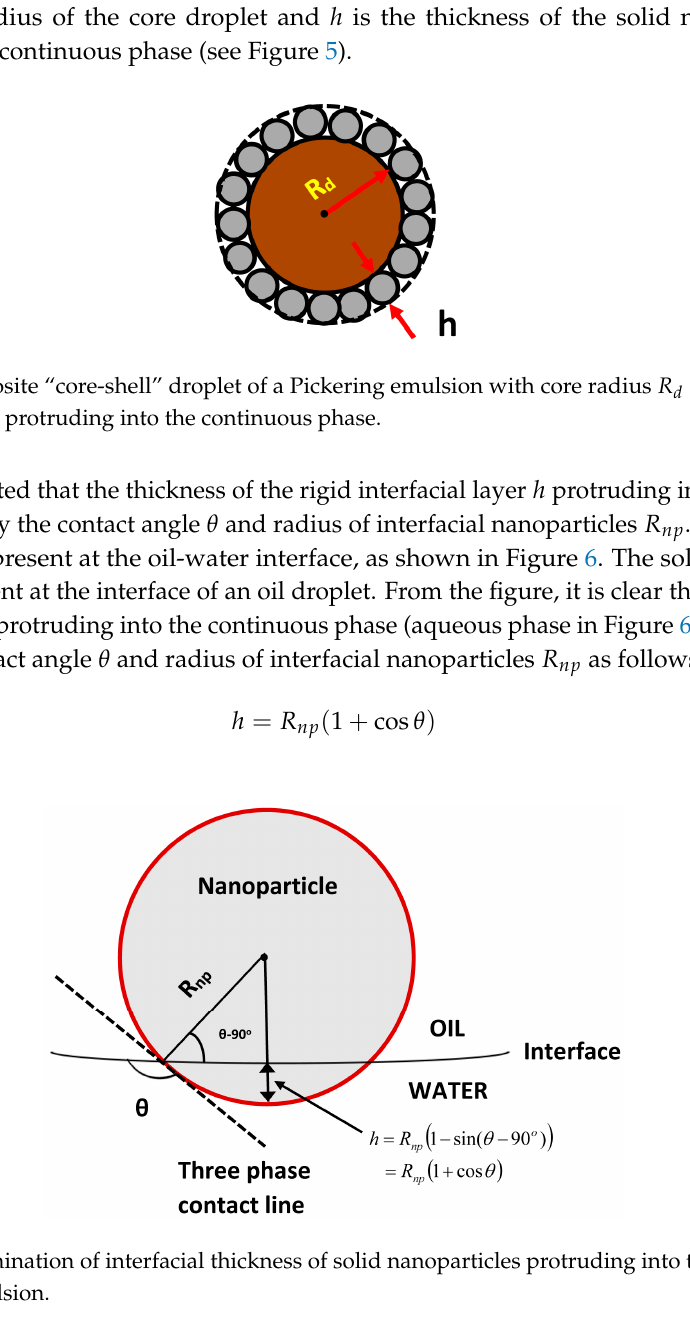
and interfacial d R